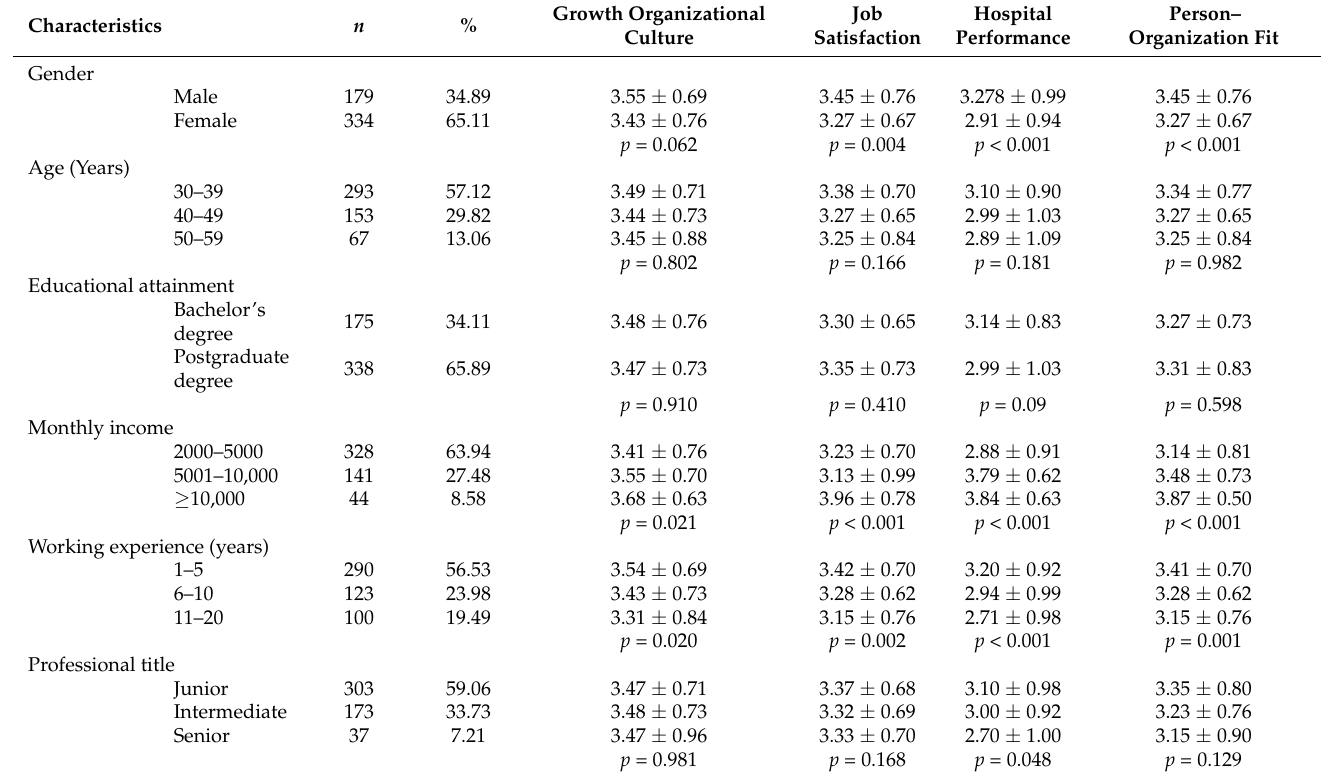
Table 1. Growth organization culture, job satisfaction, person–organization fit and hospital perfor- mance reported by the study participants by sociodemographic characteristics.